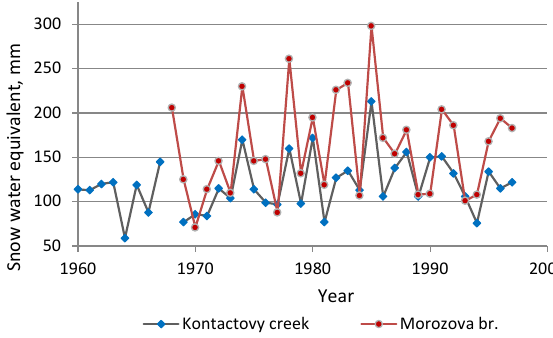
Figure 11. Snow water equivalent at the Kontaktovy creek and Mo- rozova brook.